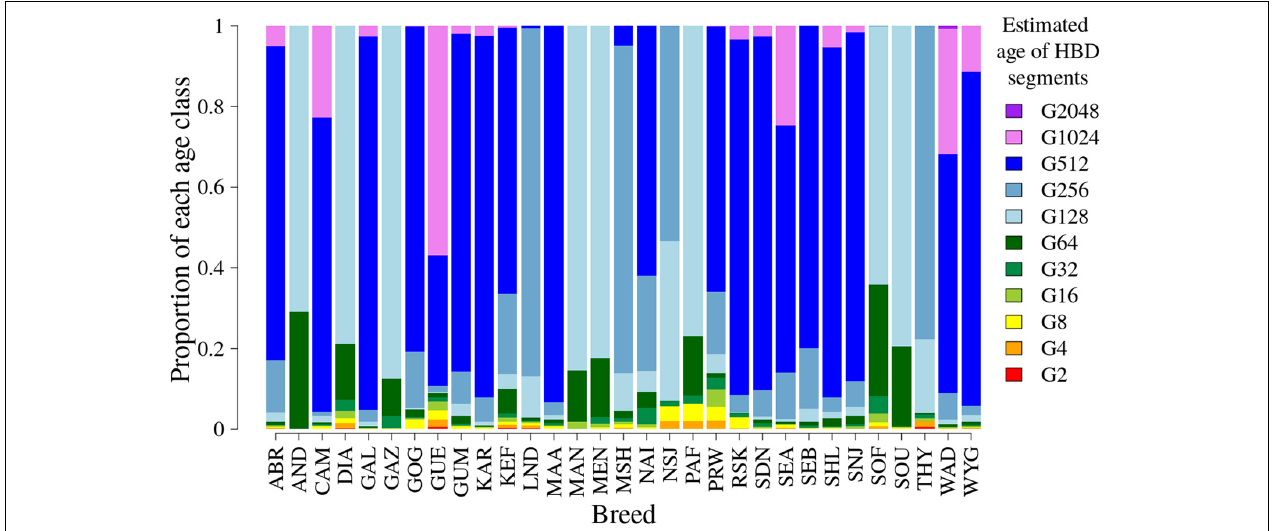
FIGURE 2 | The distribution of the mean proportion of number of segments for the 11 HBD classes. Each HBD class corresponds to the generation from which the segments originated, starting from the second generation (G2) to generation number 2048 (G2048). Breed codes: ABR, Abergelle (Ethiopia); AND, Androy (Madagascar); CAM, Cameroon (Cameroon); DIA, Diana (Madagascar); GAL, Galla (Kenya); GAZ, Gaza (Mozambique); GOG, Gogo (Tanzania); GUE, Guéra (Mali); GUM, Gumez (Ethiopia); KAR, Karamoja (Uganda); KEF, Keffa (Ethiopia); LND, Landim (Mozambique); MAA, Maasai (Tanzania); MAN, Manica (Mozambique); MEN, Menabe (Madagascar); MSH, Mashona (Zimbabwe); NAI, Naine (Mali); NSJ, Nsanje (Malawi); PAF, Pafuri (Mozambique); PRW, Pare White (Tanzania); RSK, Red Sokoto (Nigeria); SDN, Soudanaise (Mali); SEA, Small East African (Kenya and Mozambique); SEB, Sebei (Uganda); SHL, Sahel (Nigeria); SNJ, Sonjo (Tanzania); SOF, Sofia (Madagascar); SOU, SudOuest (Madagascar); THY, Thyolo (Malawi); WAD, West African Dwarf (Cameroon and Nigeria); WYG, Woyito Guji